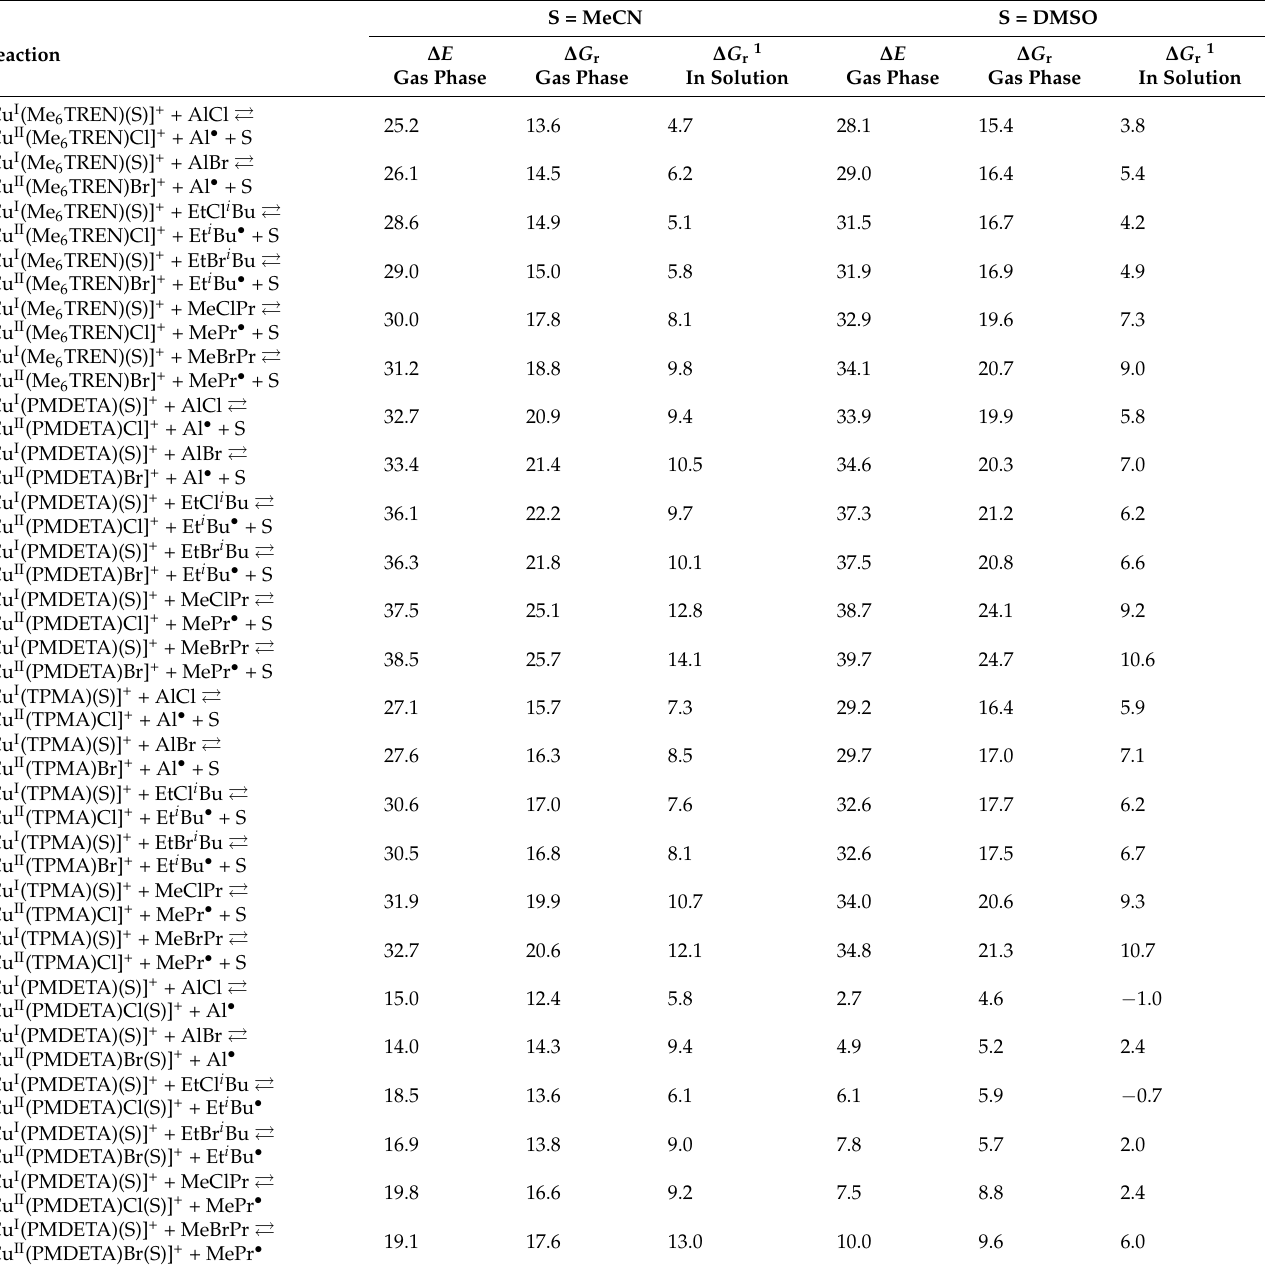
Table 6. ∆ E r and ∆ G r (kcal/mol) of reaction (1) calculated in gas phase and in solution; level of theory: